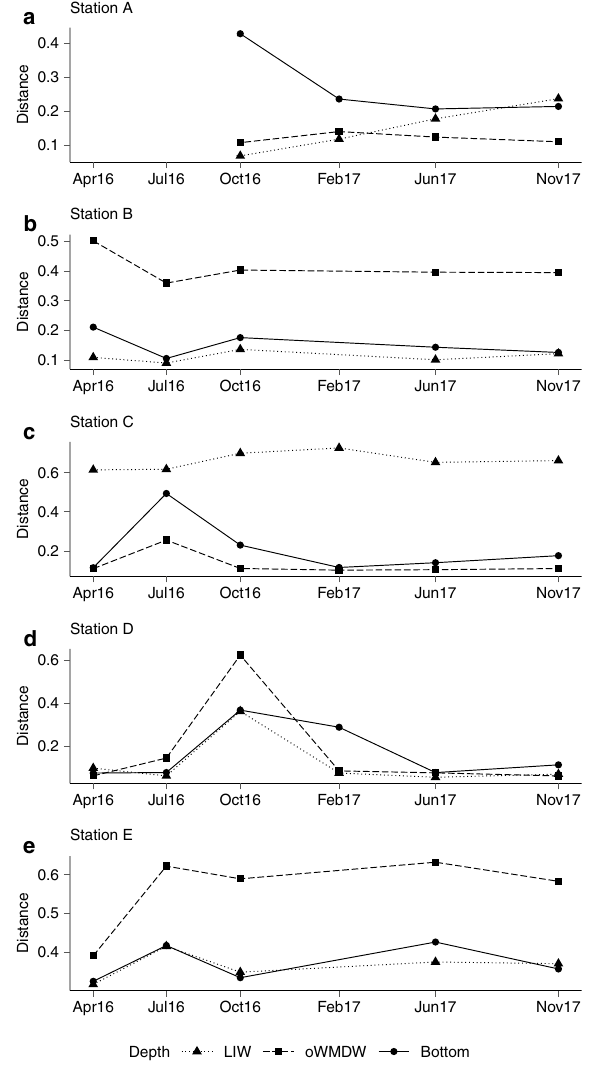
Figure 4. Temporal dynamics of the meso- and bathypelagic prokaryotic communities. Changes in community composition versus time based on pairwise weighted UniFrac distances between the different communities (from Apr16 to Nov17) and the initial community (first sampling, in Feb16) for stations ( a ) A, ( b ) B, ( c ) C, ( d ) D and ( e ) E. Shapes and line types indicate water masses: LIW: Levantine intermediate water; oWMDW: old western Mediterranean deep water. Significance ( P value) of changes is shown in Supplementary Table